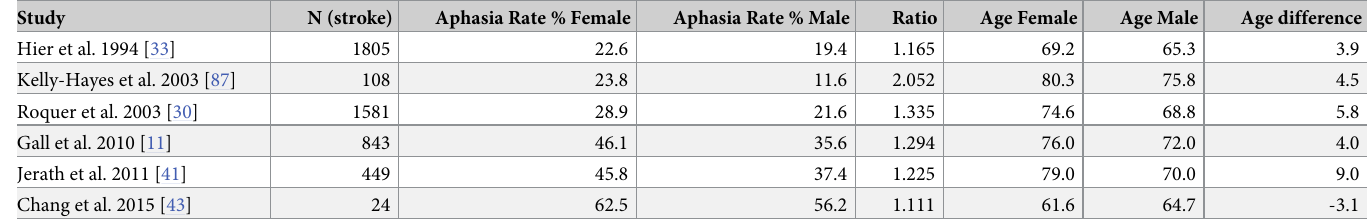
Table 2. Studies in the meta-analysis with age